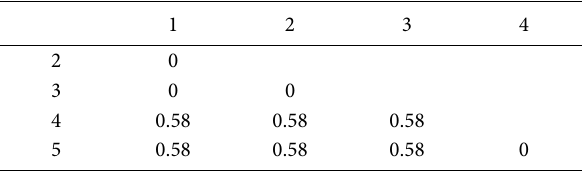
Table 9. Genetic distance among jujube cultivars based on cp-DNA PSBA sequences (populations numbers are according to Table 2).